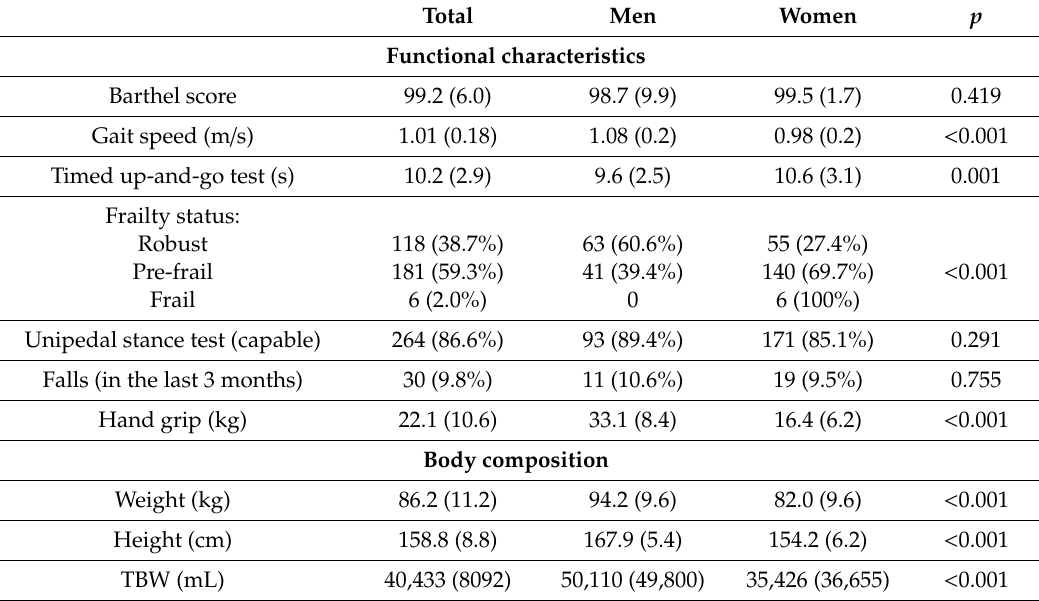
Table 1. Functional and body composition characteristics of the study